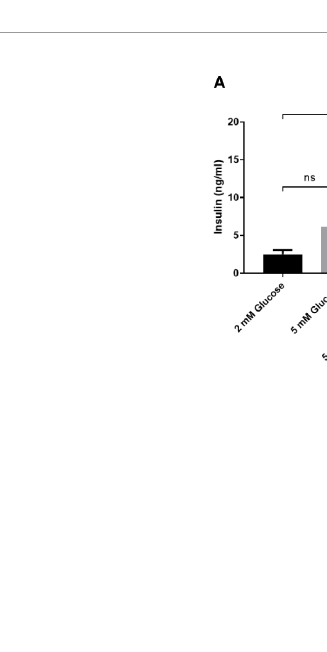
FIGURE 1 | GLP-1-stimulated recruitment of b -arrestin in PathHunter ® eXpress GLP1R CHO-K1 b -arrestin cells. (A) Inhibition of GLP-1-stimulated recruitment of b -arrestin by Cpd A; (B) Inhibition of GLP-1-stimulated recruitment of b -arrestin by Cpd B; (C) IC 50 determination of Cpd A and Cpd B Values represent the mean of three data points ± SEM. For (A, B) Statistical comparison are assessed by one-way ANOVA with Dunnett ’ s multiple comparisons test. ****P < 0.0001; ns, not signi fi